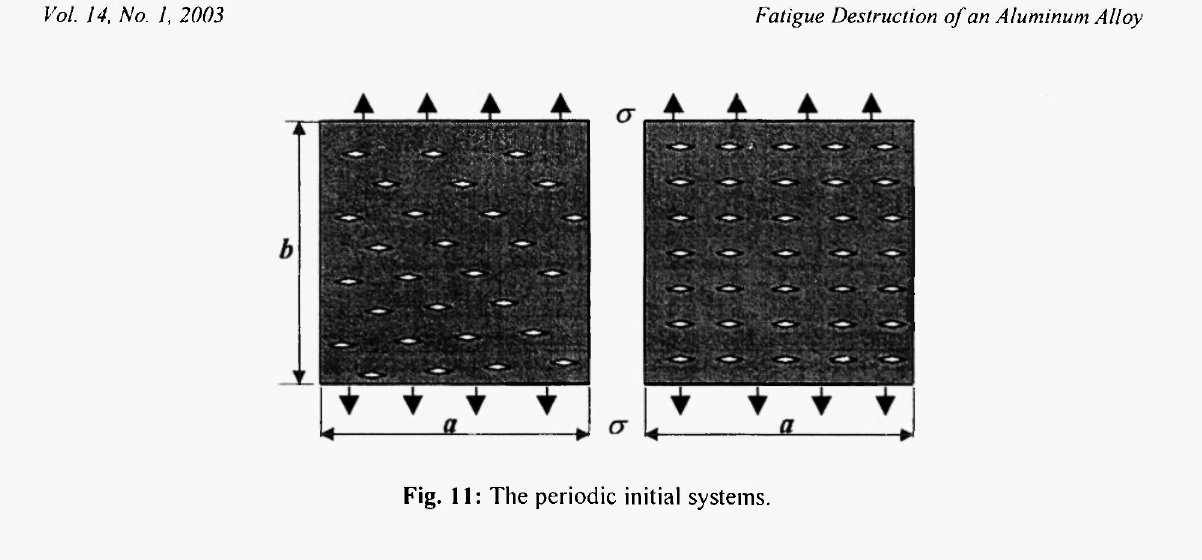
Fig. 11: The periodic initial systems.